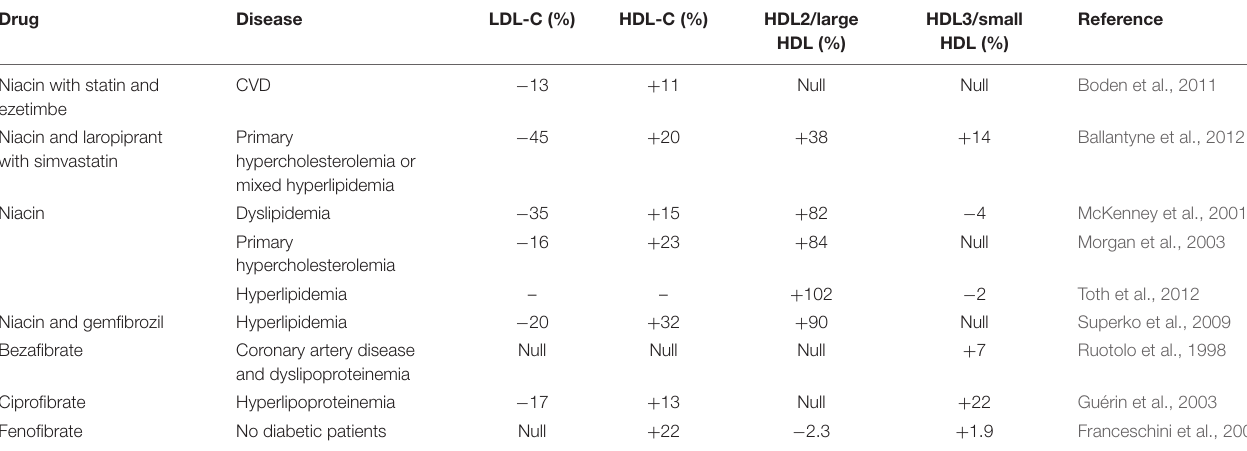
TABLE 3 | Impact of niacin and fibrate therapy on patient lipid profile. Drug